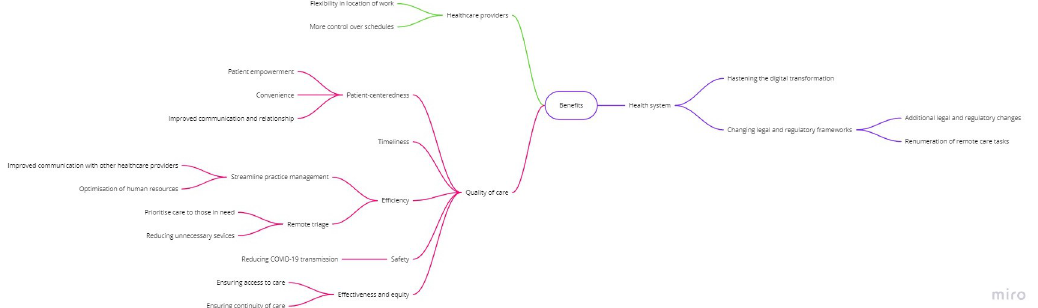
Fig 1. Conceptual map of main benefits